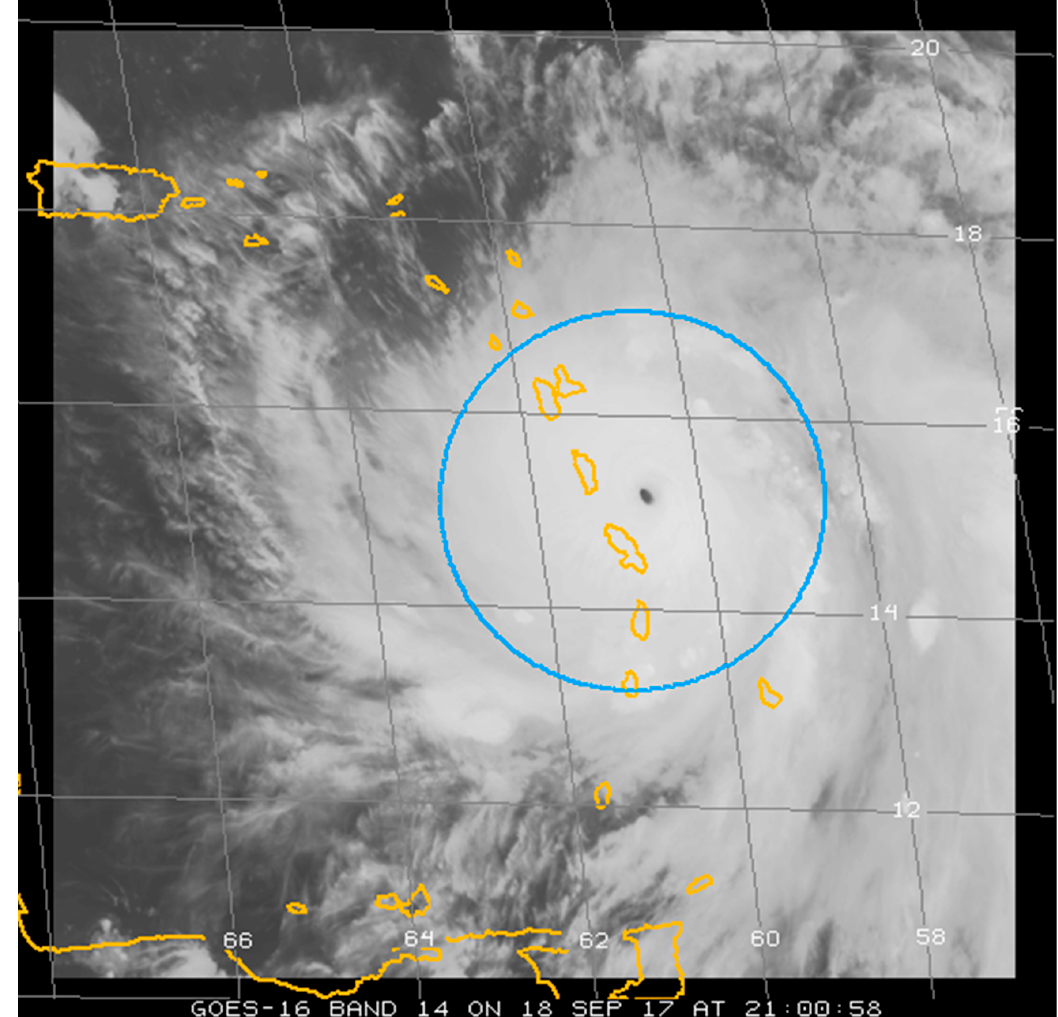
Figure 1. Example of the GOES-16 mesoscale domain sector coverage during Hurricane Maria as it approaches the eastern Caribbean Islands. Shown is an IR image on 18 September 2017. The blue circle approximates the storm central dense overcast region as described in the text. Longitudes are plotted as positive West, coastal outlines and islands are plotted in gold.